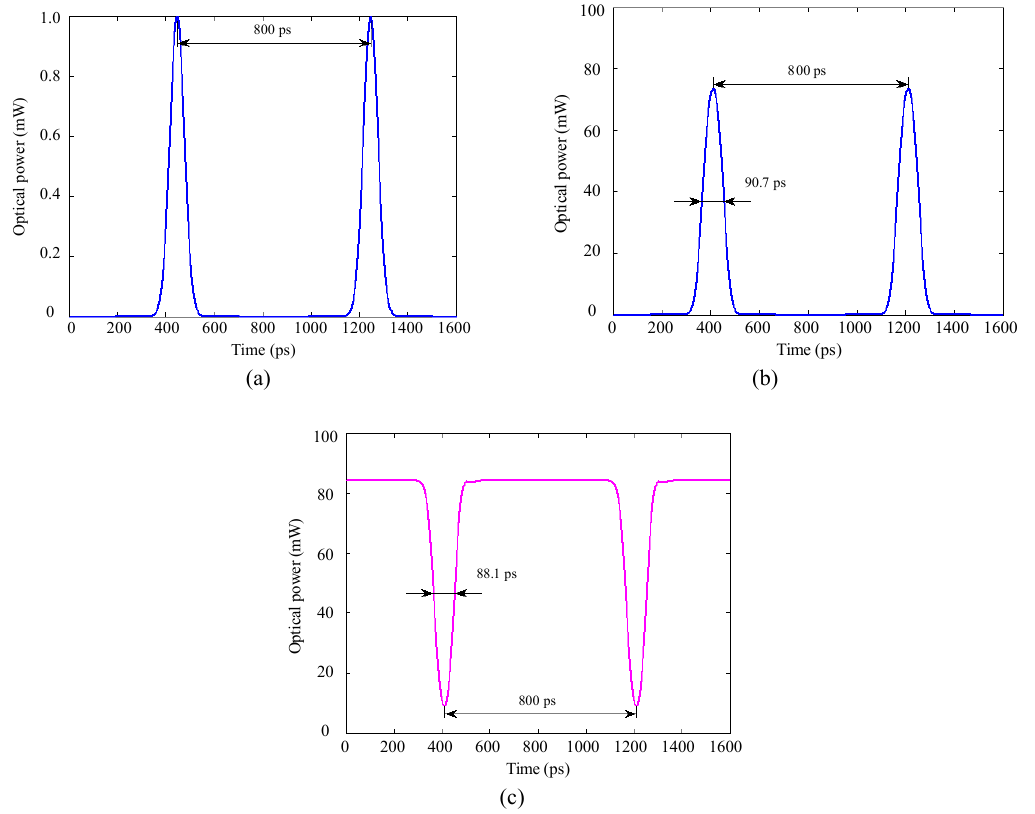
Fig. 2 Waveforms of different lights: (a) input pump, (b) output pump, and (c) output